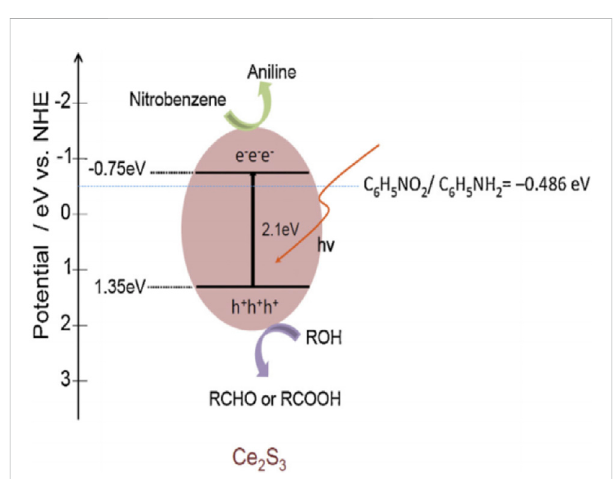
FIGURE 7 Mechanism of SHN catalyzed by Ce 2 S 3